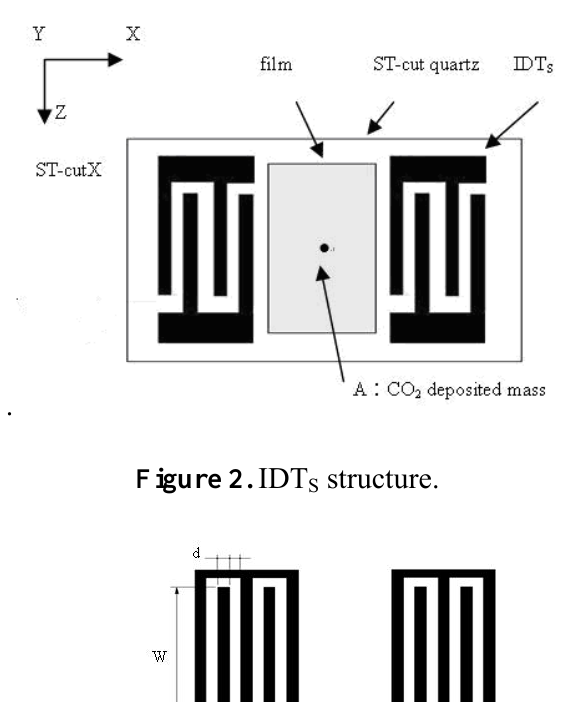
Figure1. Schematic of SAW sensor model.